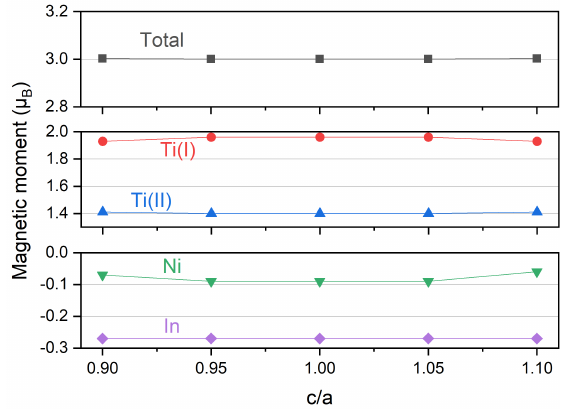
Figure 7. Total and atom-resolved magnetic momentum for Ti 2 NiIn compound under tetragonal deformation of different c/a ratio. Atomic site is referred as the inset crystal structure in Figure 1.